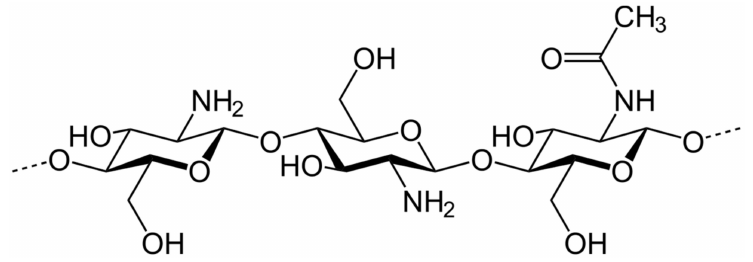
Figure 1. Chemical structure of chitosan